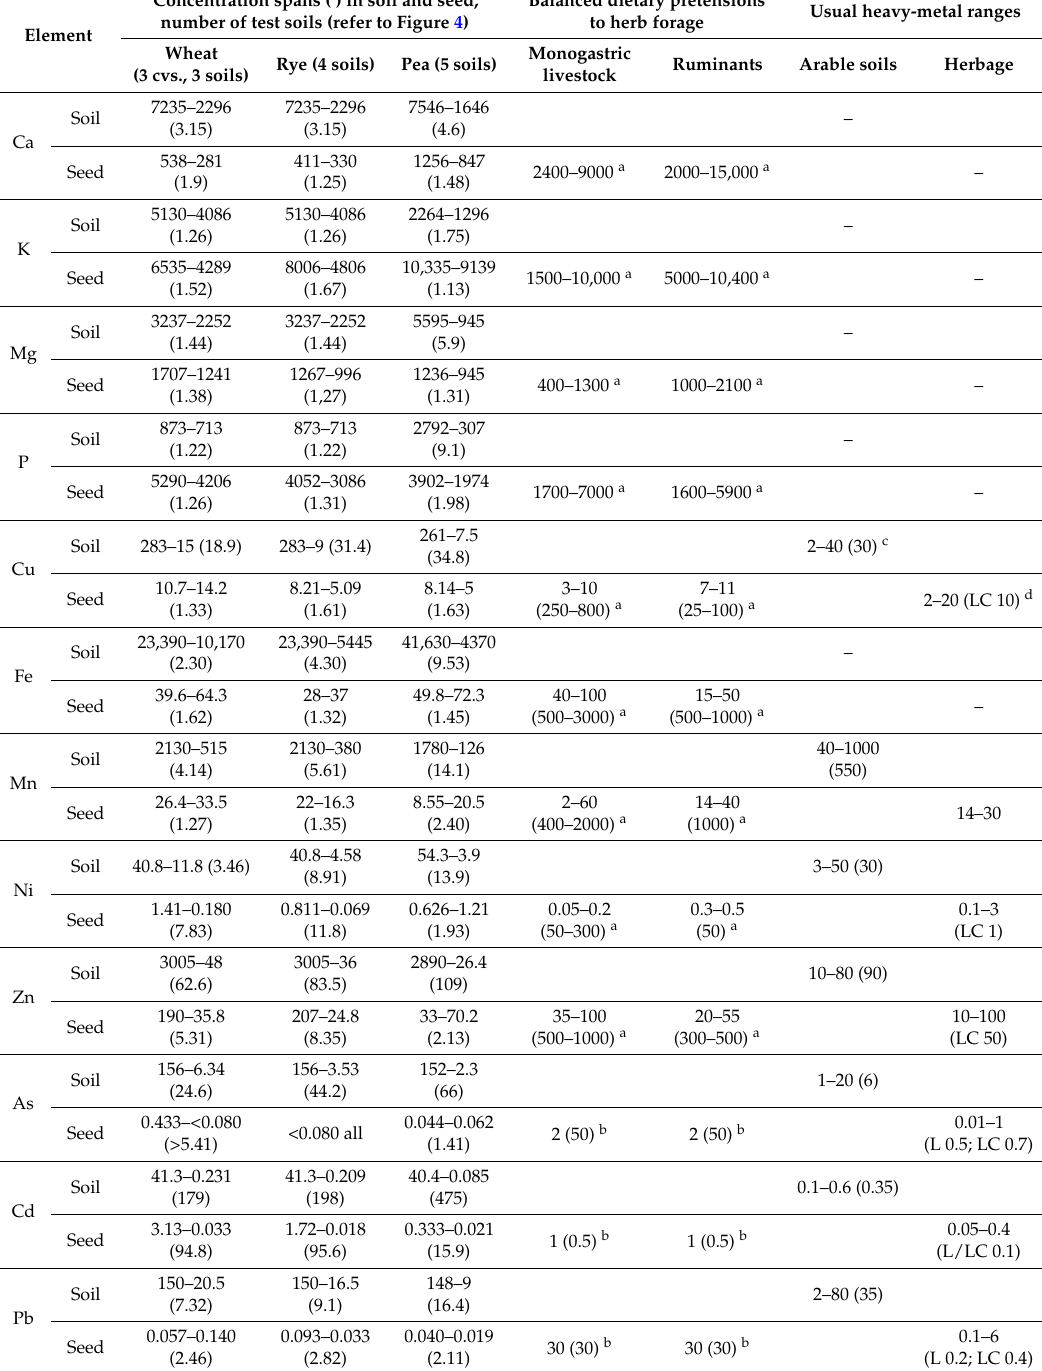
Table 4. Wide concentration spans ( ) in sets of HM-contaminated and non-contaminated arable soils diminish drastically in seeds. The resulting seed mineral loads correspond with the dietary pretensions of (livestock) herbivores and human and indicate uptake repression to AsCdPb toxicants. All values are given in mg kg ´ 1 DW. Adapted from primary data of Gramss and Voigt [18,27]. Concentration spans ( ) in soil and seed, number of test soils (refer to Figure Element